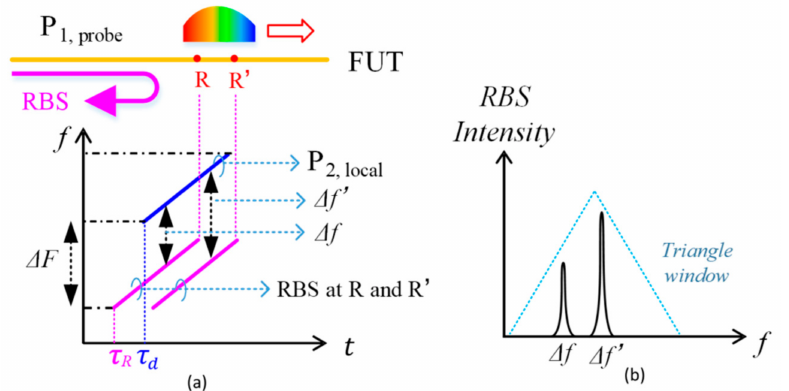
Figure 2. Principle of section access. ( a ) The RBS at positions R and R’ mix with the reference to generate beat frequencies; ( b ) the detected beat signal is applied by a triangle